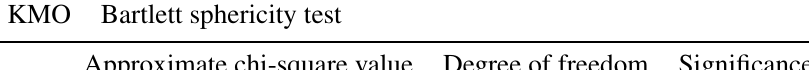
Table 5 KMO and Bartlett test.